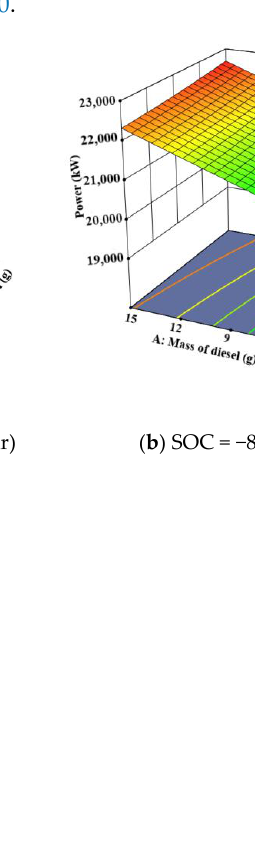
Figure 7. Response surface plot of the power.